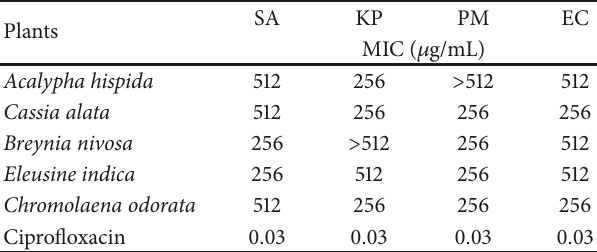
Table 5: Minimum inhibitory concentration (MIC) of selected medicinal plants against bacterial strains associated with oral and skin